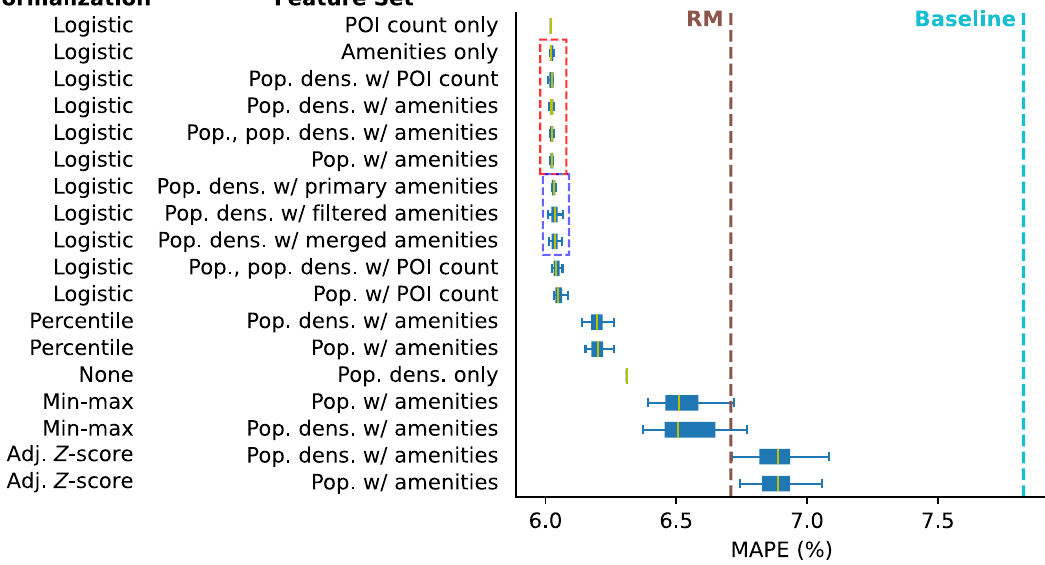
Figure 3. Model performance based on mean absolute percentage error (MAPE). Models in broken-line boxes are not significantly different based on ANOVA. Logistic z- score normalization is the best method of normalization, outperforming Percentile , Min-max and Adjusted z- score normalizations in all instances. The best performing model uses only the number of points of interest in a locality as feature and follows Logistic z- score normalization. It corresponds to a 10.3% MAPE improvement relative to Radiation Model. All models beat the baseline model which is the outright scaling of locality population according to the same rate of change in the national population. The performance metrics of all of the 61 configurations that were investigated are displayed in Supplementary Table